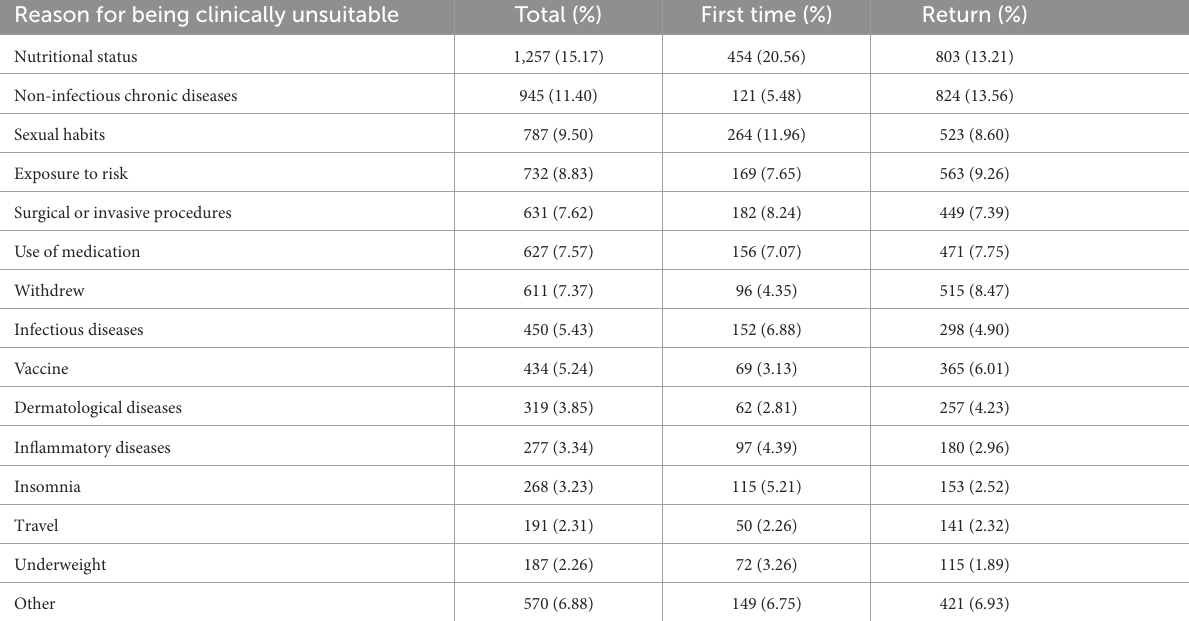
TABLE 2 Reasons for being unsuitable during clinical screening in the 2017–2019 triennium. Reason for being clinically